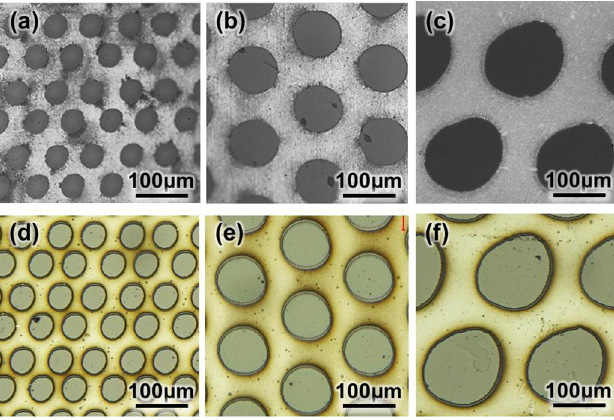
Fig. 13. Optical microscopic images of the laser processed metallic masks with different diameter D of 50 m m (a), 100 m m (b) and 150 m m (c) with a constant DLC coverage and that of the corresponding micro-textured DLC (d – f).